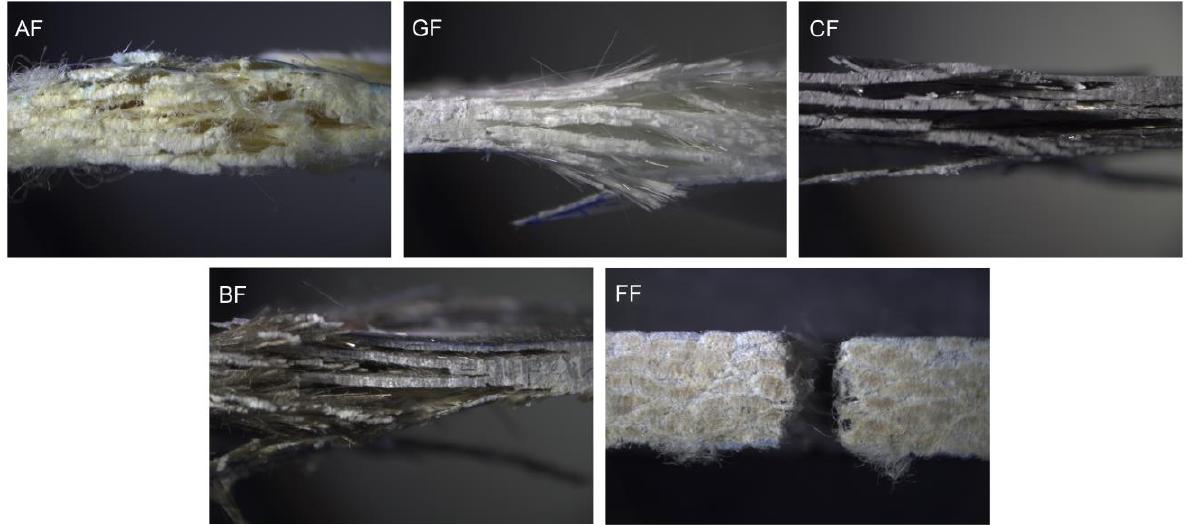
Figure 8. Profile view of the composite samples after tensile test by an optical